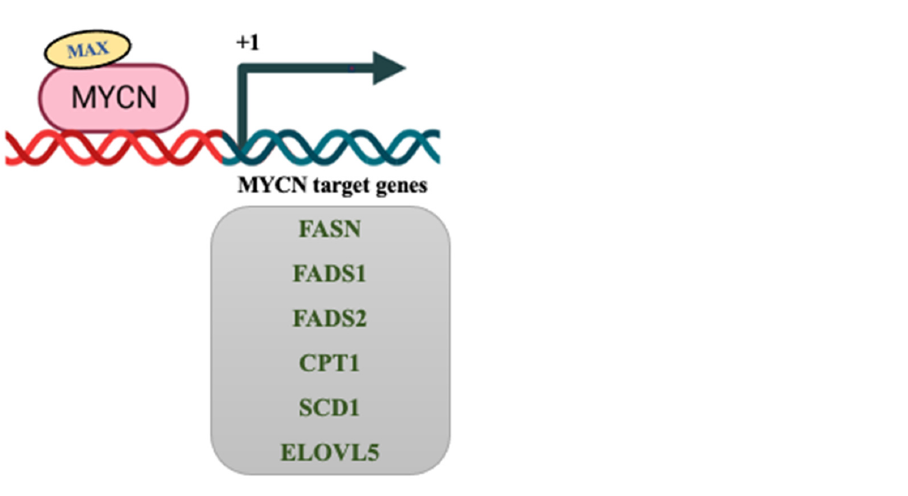
Figure 4. Possible regulation of key lipid metabolic enzymes by MYCN. The promoter sequence of important lipid metabolic enzymes was analyzed for the presence of MYC-binding E-boxes. The